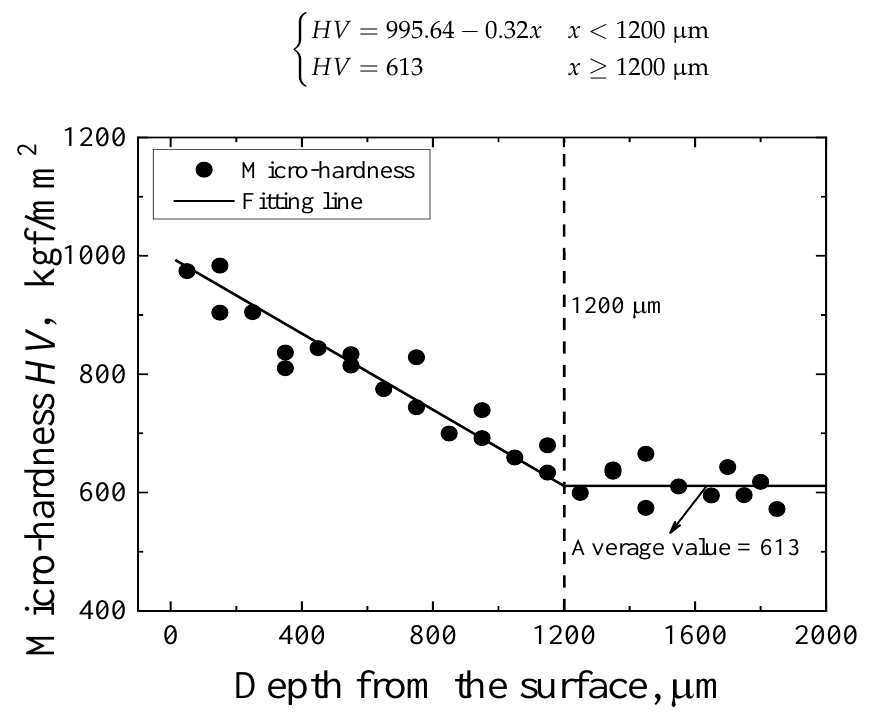
Figure 3. The relationship between the Vickers hardness ( HV ) and the distance from the surface depth.